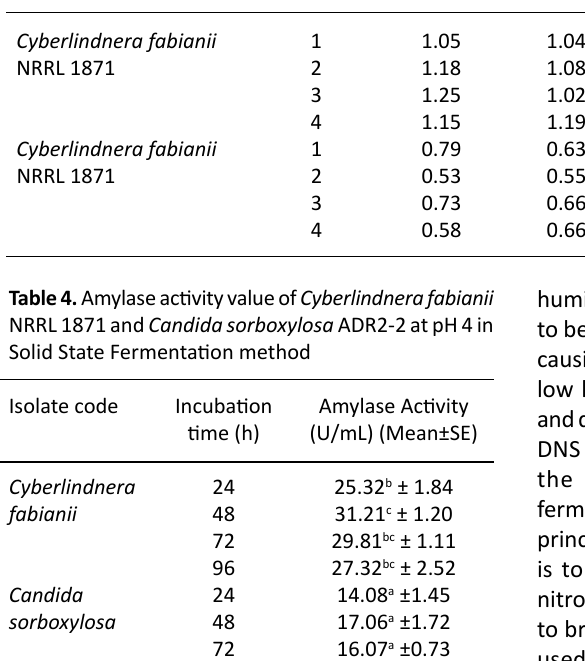
table 3. Average absorbance value of of Cyberlindnera fabianii NRRL 1871 and Candida sorboxylosa ADR2-2 at 540 nm wavelength Isolate code